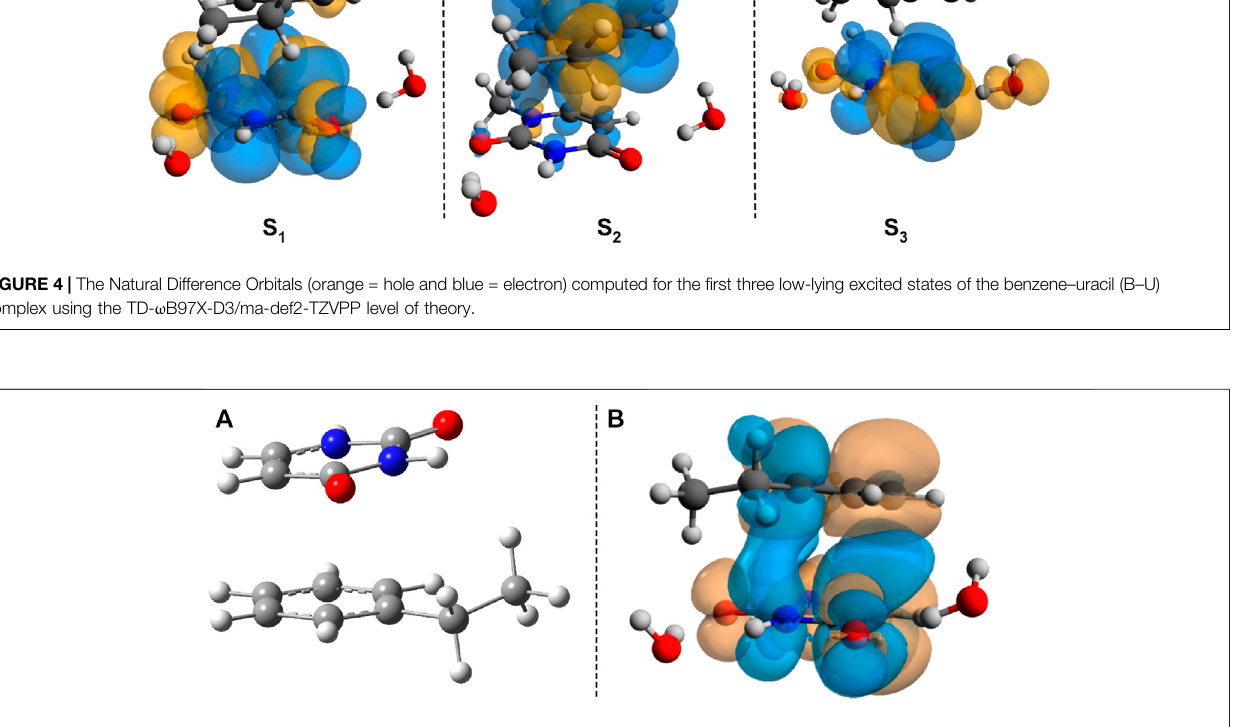
FIGURE 5 | (A) The intermediate geometry along the S 1 energy relaxation channel. (B) The Natural Difference Orbitals (NDO) of the S 1 excited state taken for the intermediate geometry.